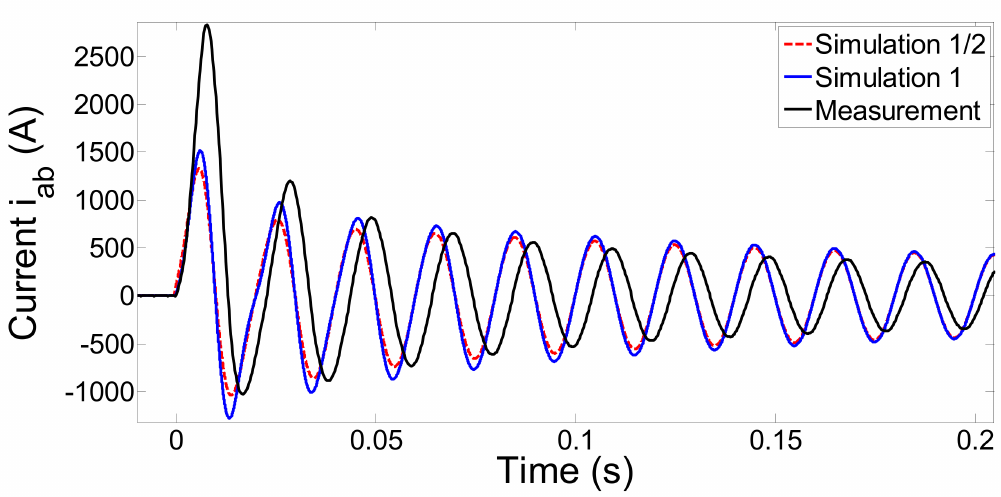
Figure 6. Comparison of simulation and measurement for the short-circuit stator